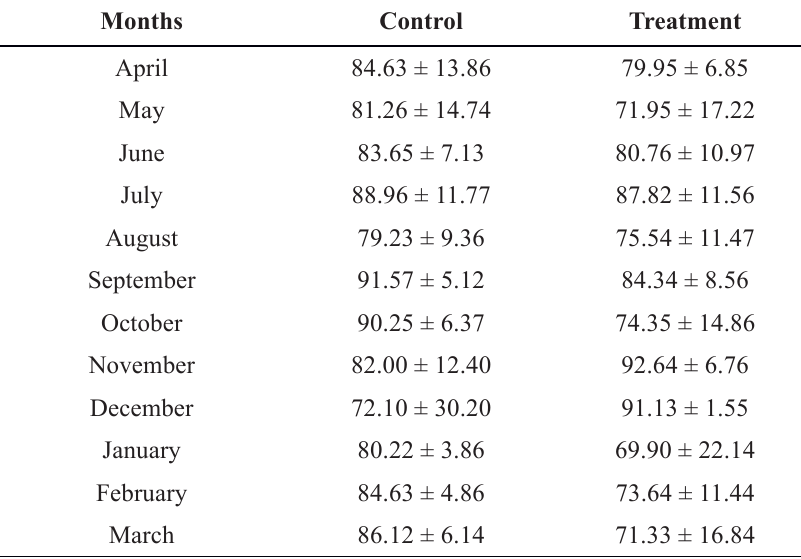
Table 2. Means and standard deviations of the hygienic behavior test (%) of African-derived Apis mellifera (L.) colonies without (Control) and with the harvest of apitoxin (Treatment), between April 2013 to March